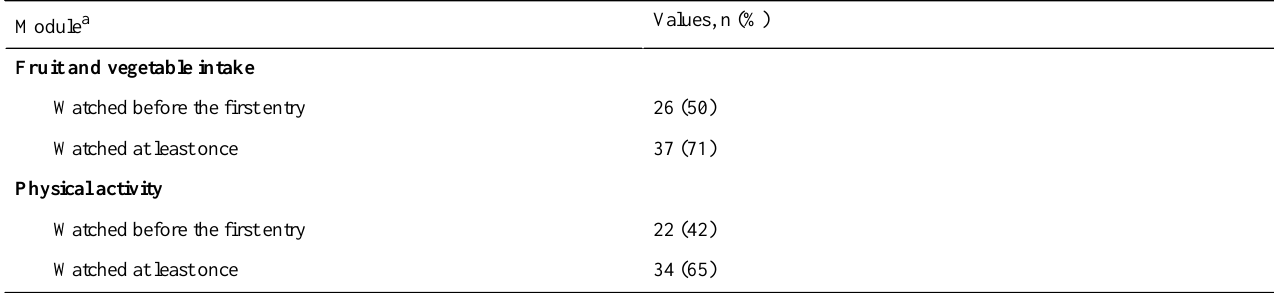
Table 3. Viewership of information slides